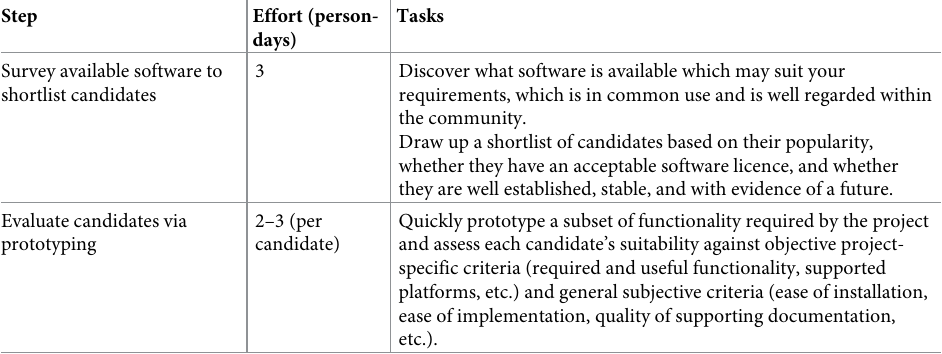
Table 1. Prototyping to select software for a